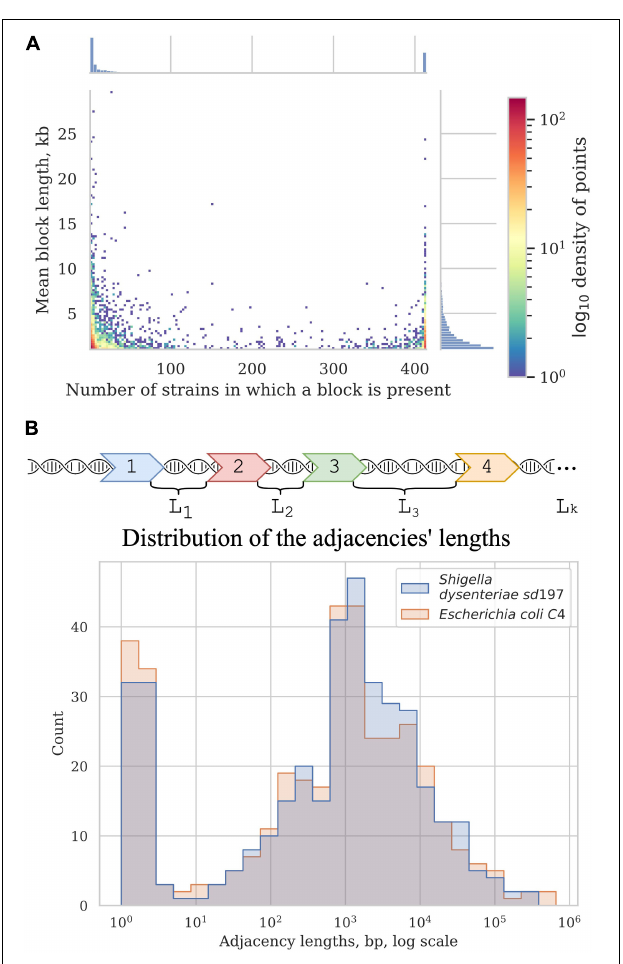
FIGURE 5 | Synteny blocks. (A) 2D histogram shows the relationship between the mean block length and the number of strains in which it is present. The colour of a point corresponds to the number of synteny blocks with these parameters. X -axis histogram shows the frequency distribution of the synteny blocks; Y -axis histogram shows the length distribution of the synteny blocks. (B) Distribution of the adjacencies’ lengths in E. coli and Shigella , in nucleotides. Adjacencies are defined as the chromosome regions between the neighbouring universal synteny blocks (see section “Materials and